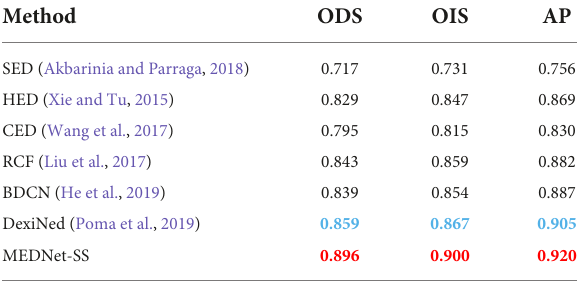
TABLE 5 Quantitative comparison results between the proposed method and other methods on barcelona images for perceptual edge detection (BIPED) test